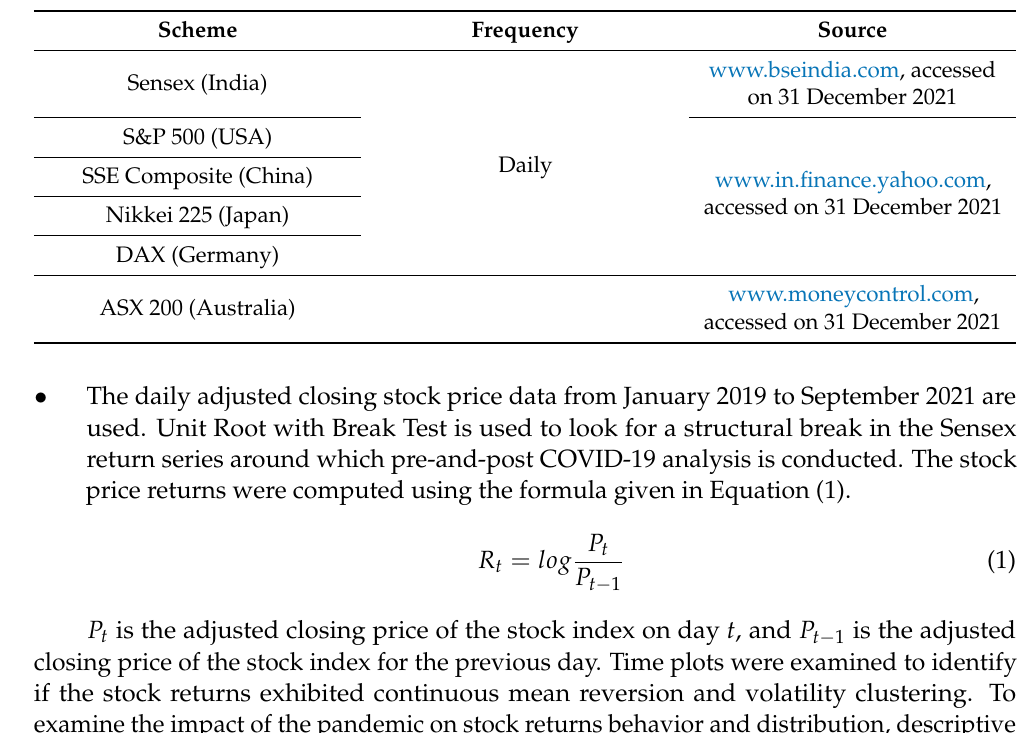
Table 1. Sources of